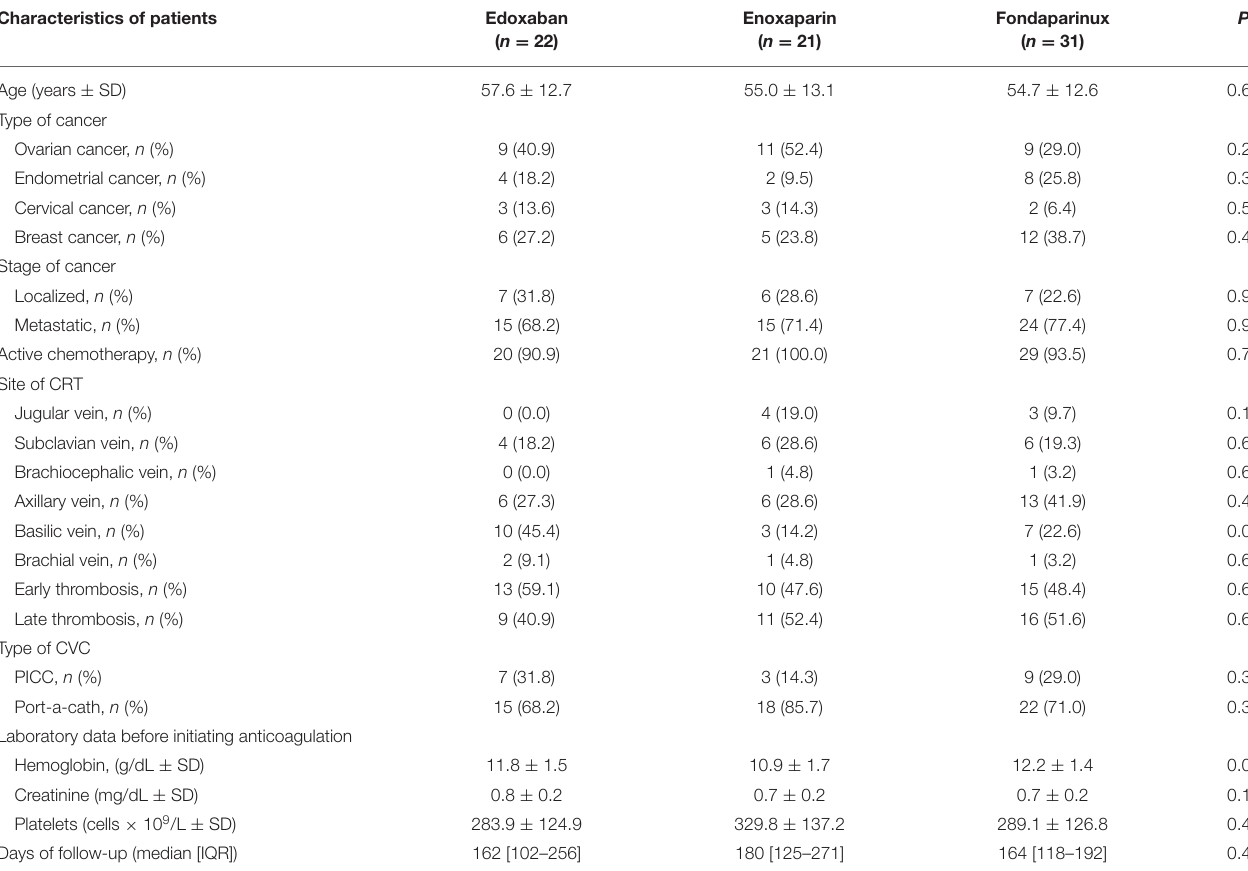
TABLE 1 | Comparison between patients treated with edoxaban, enoxaparin, and fondaparinux. Characteristics of